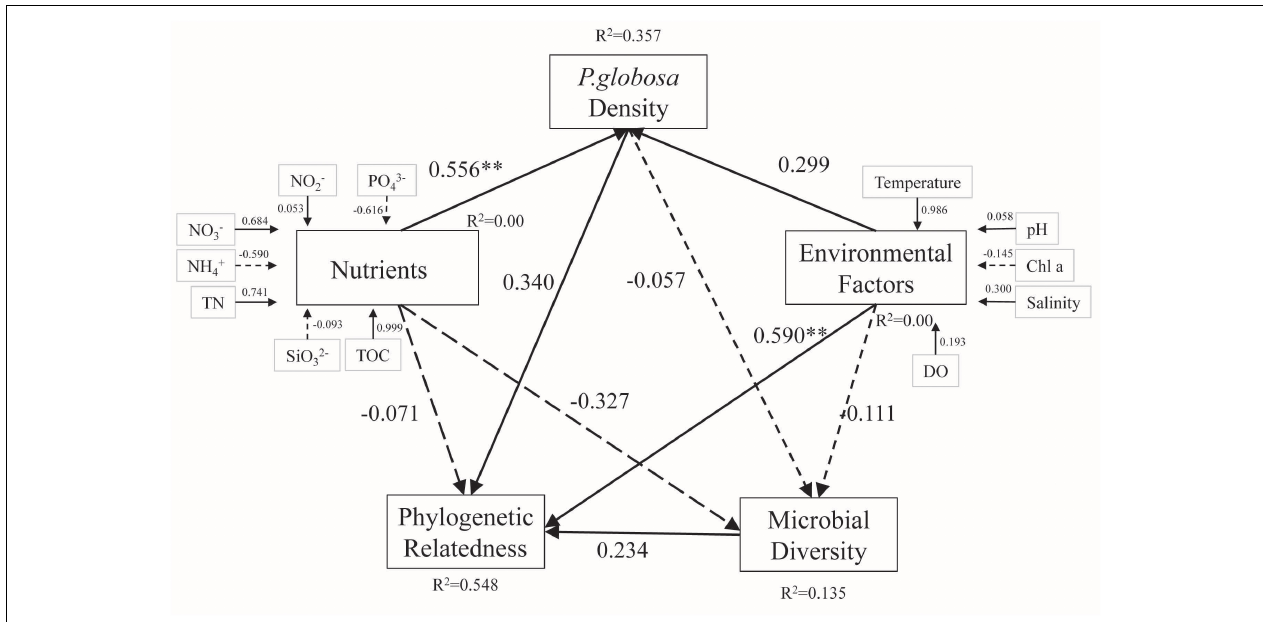
FIGURE 7 | Path model based on the effects of environmental variables and relative abundance, diversity, and phylogenetic relatedness of the microbial community in marine waters with various P. globosa density levels. Solid and dotted lines indicate positive and negative effects, respectively. Asterisks indicate statistical significance (** p <